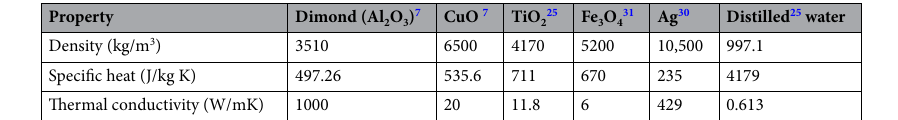
Table 1. Thermophysicallproperties of nanoparticles.